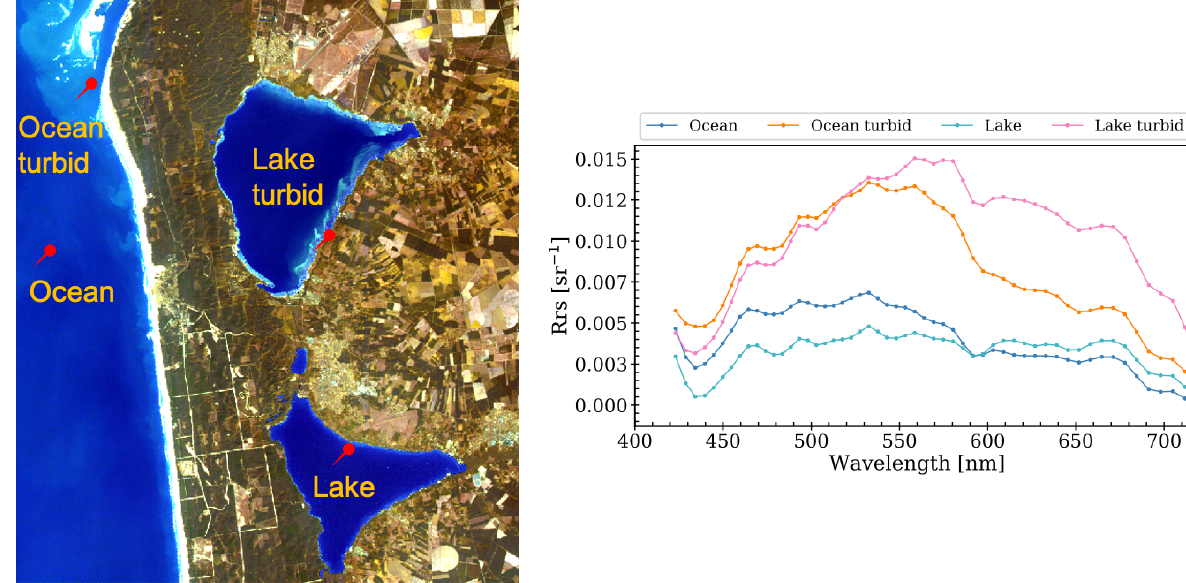
Figure 9. True-color image composite of the simulated EnMAP level 1B data [46] at lake Cazaux et de Sanguinet, located south of Arcachon, France, on 8 November 2017. The spectral signature of four different water types after Polymer was applied to the level 1B data in sensor geometry. The spectra were smoothed using a Gaussian filter with standard deviation of